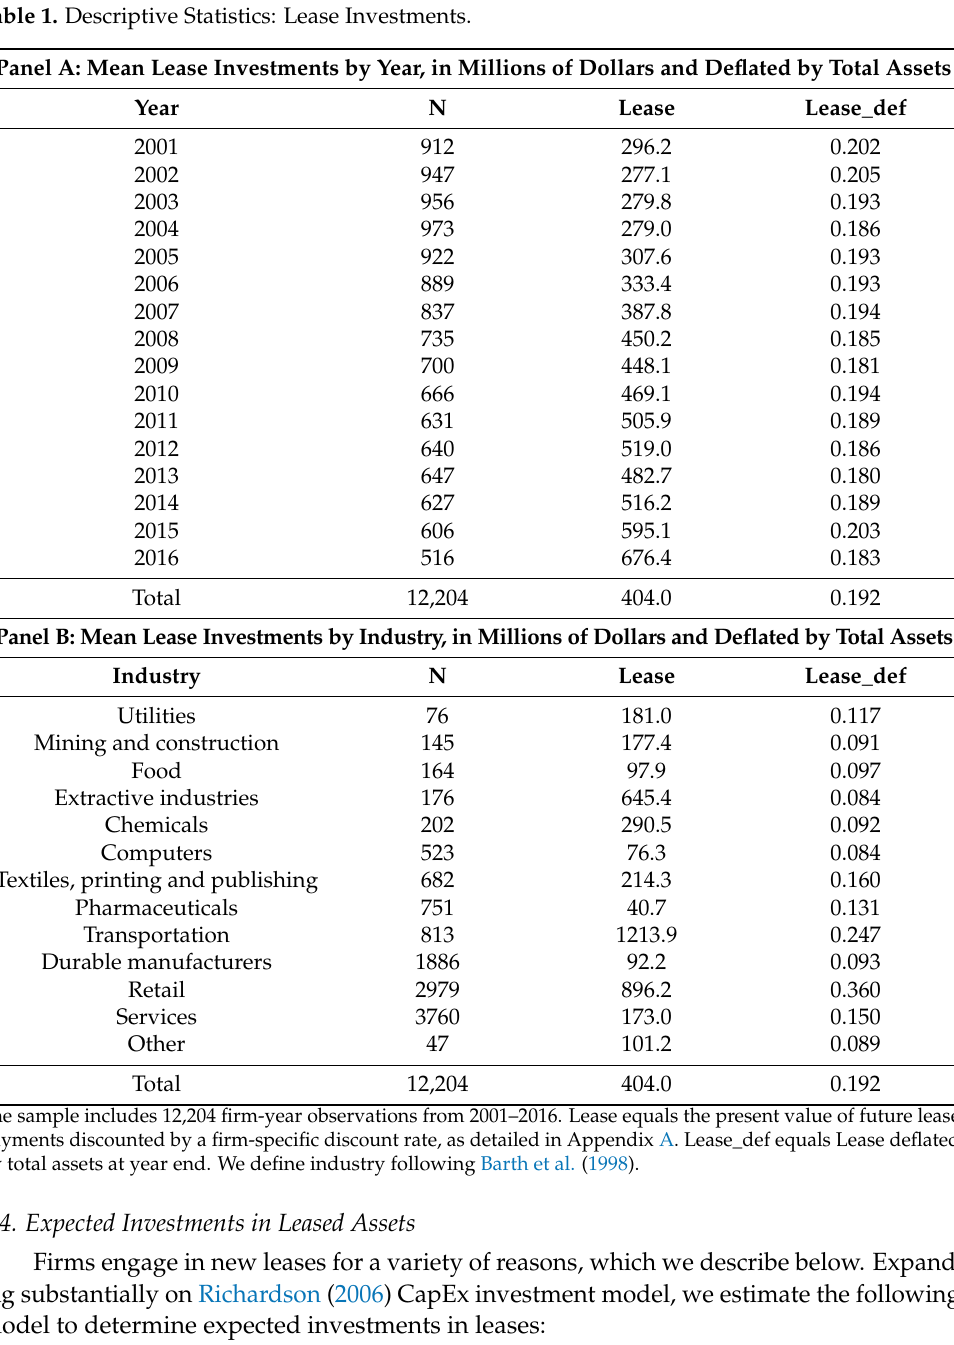
Table 1. Descriptive Statistics: Lease